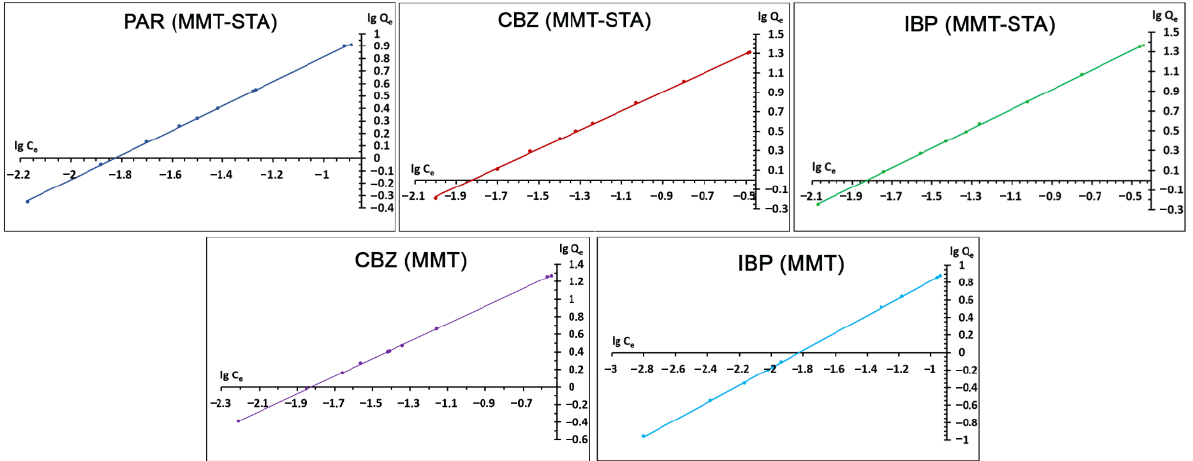
Figure 5. Adsorption of pharmaceuticals onto clay fitted to linearized form of Freundlich isotherm. The fitting parameters of the model K f and n are presented in Table 2. The value